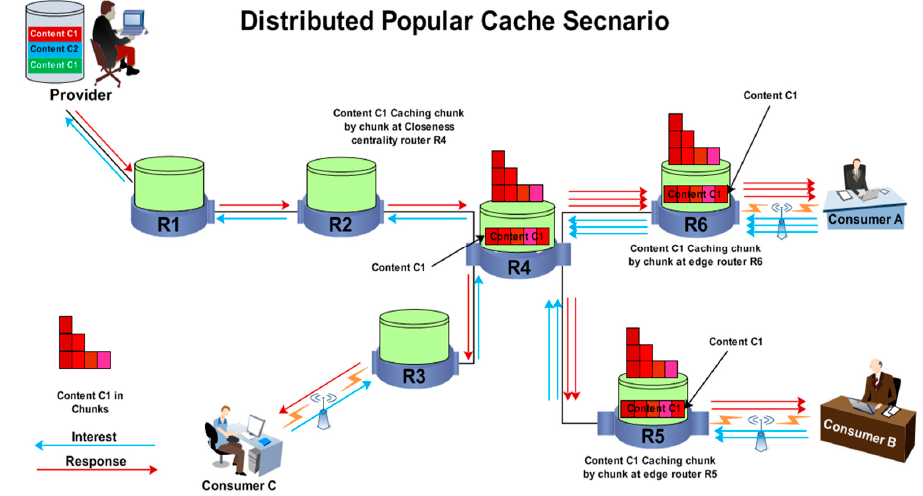
Figure 6. Distributed Caching Strategy.